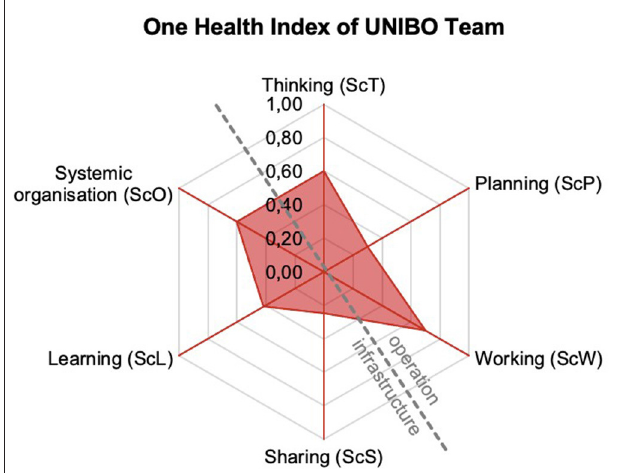
FIGURE 3 | The NEOH spider diagram for the OH-ness evaluation of the UNIBO team. Spider diagram based on the overall scores (from 0 to 1, solid lines) of the six dimensions for the One Health Index (OHI) of the UNIBO Team (the red structure) from the One Health (OH) perspective. The dashed line represents the division of the diagram into operation and infrastructure for representing the One Health Ratio (OHR) of the UNIBO